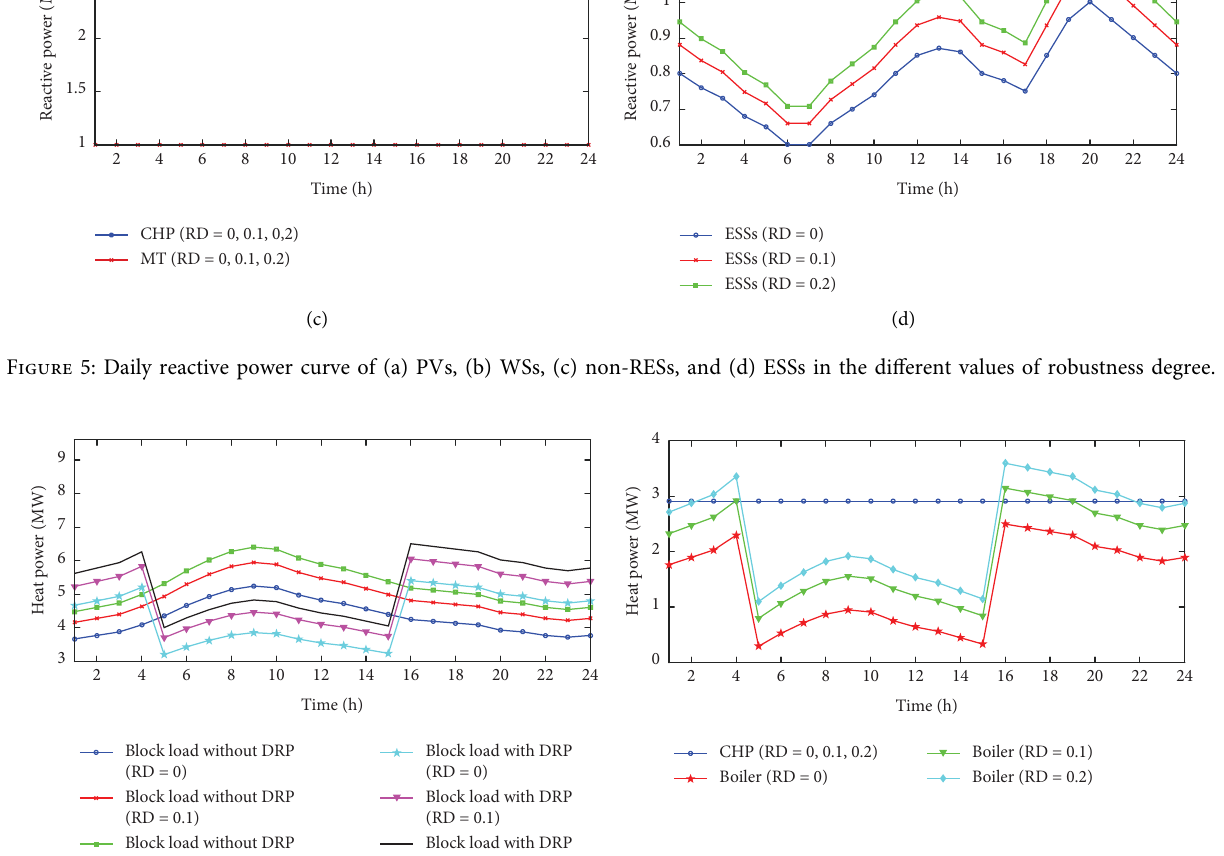
Block load without DRP (RD = 0) Block load without DRP (RD = 0.1) Block load without DRP (RD = 0.2) Figure 6: Daily heat power curve of (a) block load without/with DRP and (b) sources in the diferent values of robustness